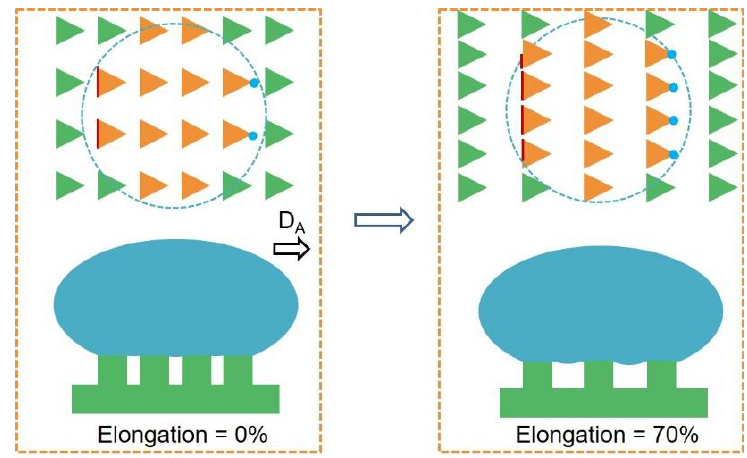
Figure 5. Schematic illustration showing the change in the contact interface between the droplet and ATM at different mechanical stretching. The orange triangles are micropillars in contact with the water droplet and the green triangles are not. The blue dash line indicates the contact perimeter.